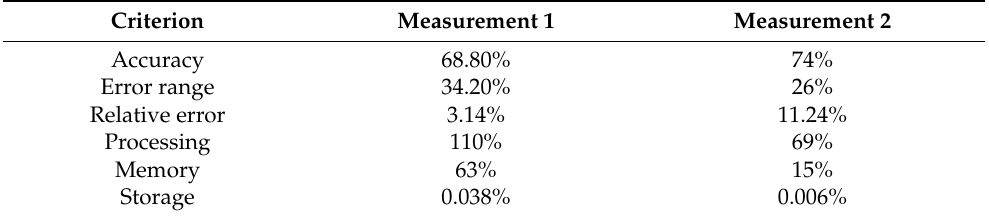
Table 2. Comparison of the model, in measurement column 1 the results of the model with tracing are presented and measurement column 2 presents an adjustment by removing the skeletonization tracing.